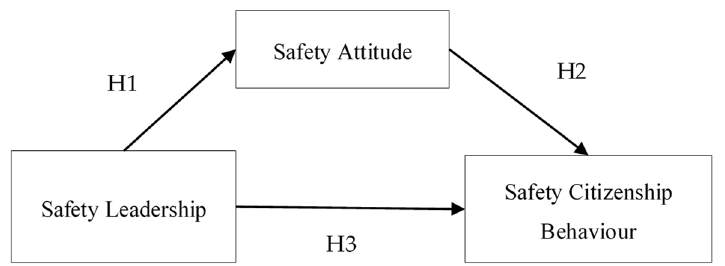
Figure 1. Framework of the influence model and the hypotheses among safety citizenship behavior (SCB), safety attitude (SA) and safety leadership (SL).